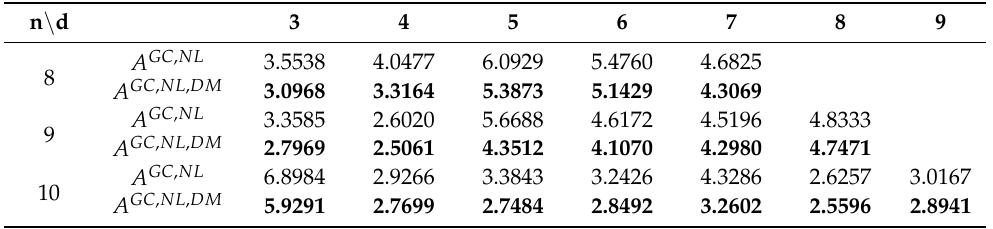
Table 8. Comparison results of the melting temperature variance, where the best results are bolded to indicate.